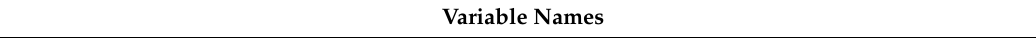
Figure 2. Prediction accuracy of SVM (support vector machine), PCA (principal component analysis) + SVM, GA (genetic algorithm) + SVM, and C4.5 (C4.5 decision tree) + SVM. Specifically, the GA, PCA, and C4.5 selected 140, 60, and 10 features from the 182 features, respectively. It is surprisingly e ff ective to use only 10 features selected by the C4.5 to distinguish patients with and without nephropathy. Table 4 lists the 10 representative features selected by the C4.5 method. Table 4. The 10 representative variables.